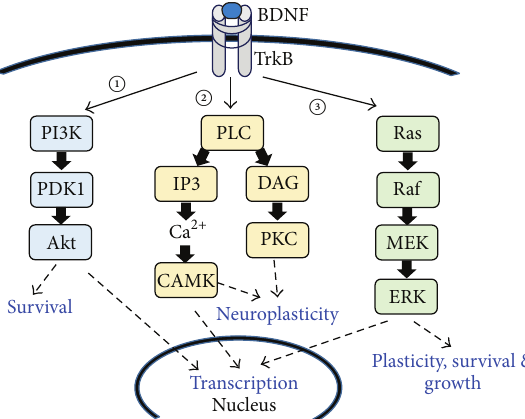
Figure 1: BDNF-TrkB dependent pathways: BDNF binds its high affinity receptor Tropomyosin-related kinase B (TrkB) and activates threemainpathways(adaptedfrom[3–5]): A thePI3K/Aktpathway which has been shown to mediate cell survival function of BDNF, B the phospholipase C (PLC) pathway which leads to the activation of protein kinase C (PKC), and C the Ras pathway which acti- vates extracellular signal-regulated kinase (ERK). Activation of the kinases, PKC and ERK, leads to posttranslational modification such as phosphorylation and transcription. These processes are critical to neuroplasticity, including central sensitization and LTP. BDNF also binds the nonselective p 75 NTR